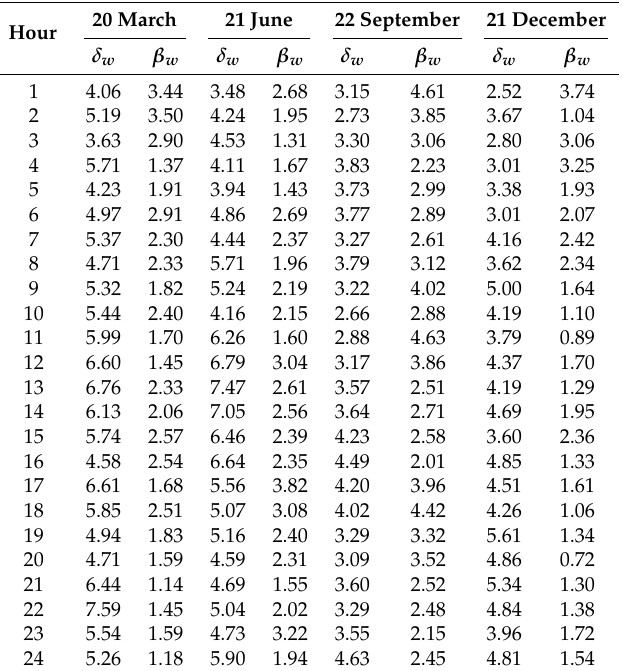
Table A4. Wind speed parameters (scale and shape) on four different